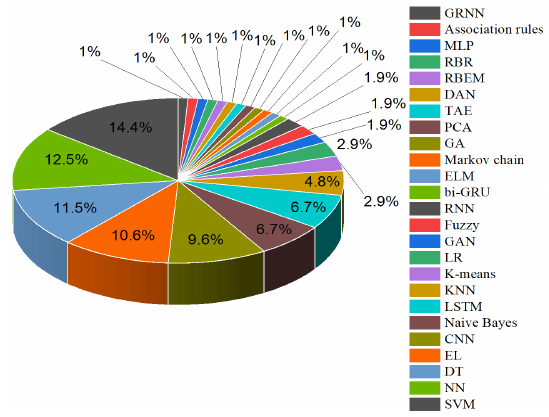
Fig. 7 ML techniques mainly used for